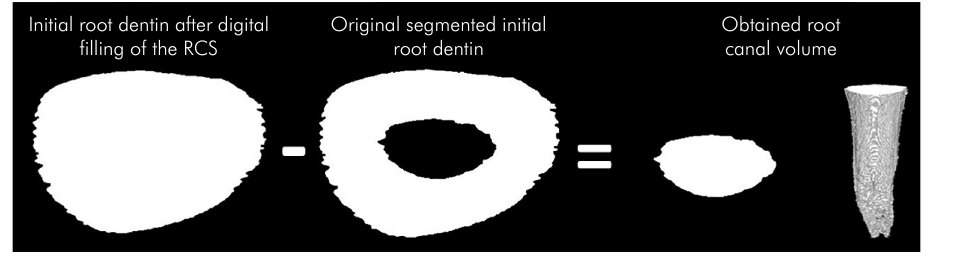
Figure 1. Depiction of the method used to obtain the sound root canal volume through arithmetic operations from baseline and instrumented